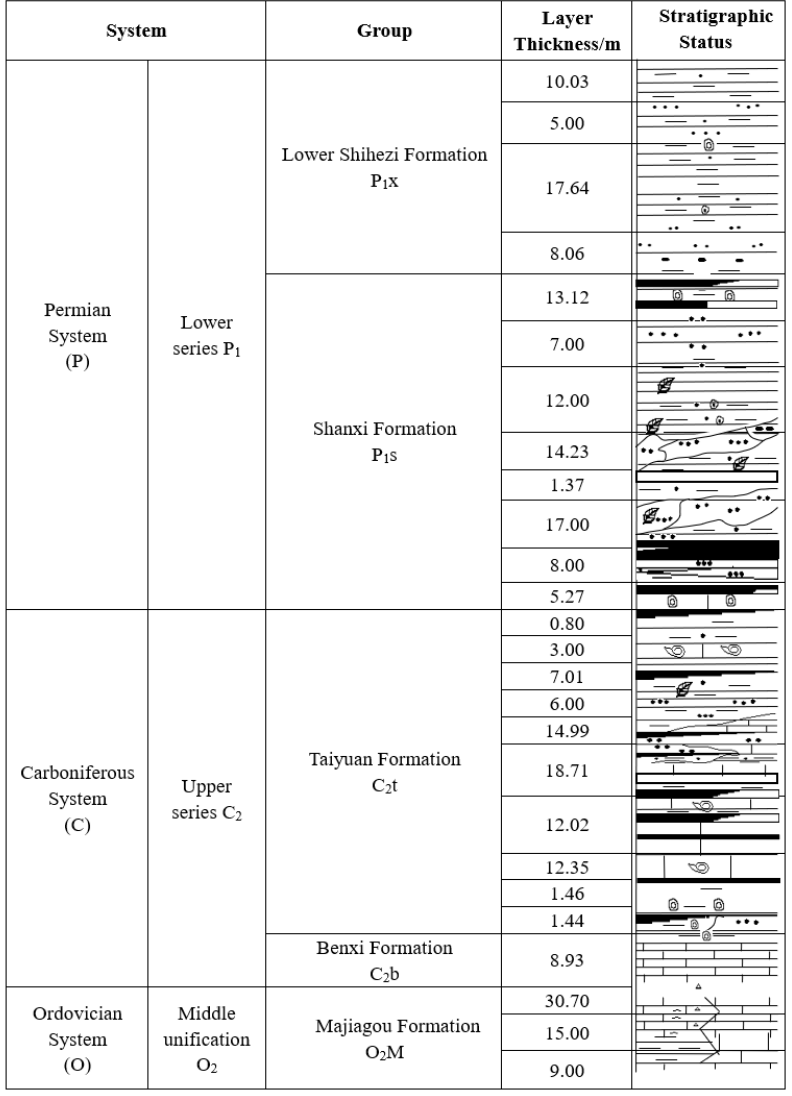
Figure 8. The integrated geological drilling histogram of the water-rich type coal mining goaf areas (modified from the geological report of this study area).